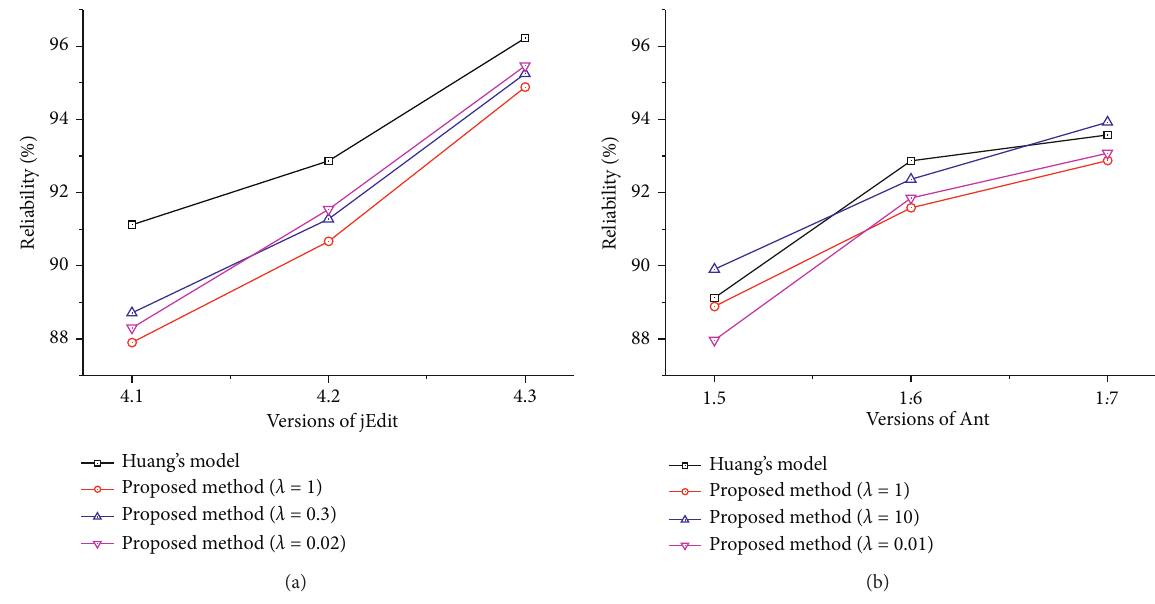
Figure 5: Reliability curves of the proposed method with different regularization rates when η is set to 0.05: (a) the regularization rate λ is set to 0.3 and 0.02 on the target jEdit; (b) λ is set to 10 and 0.001 on the target